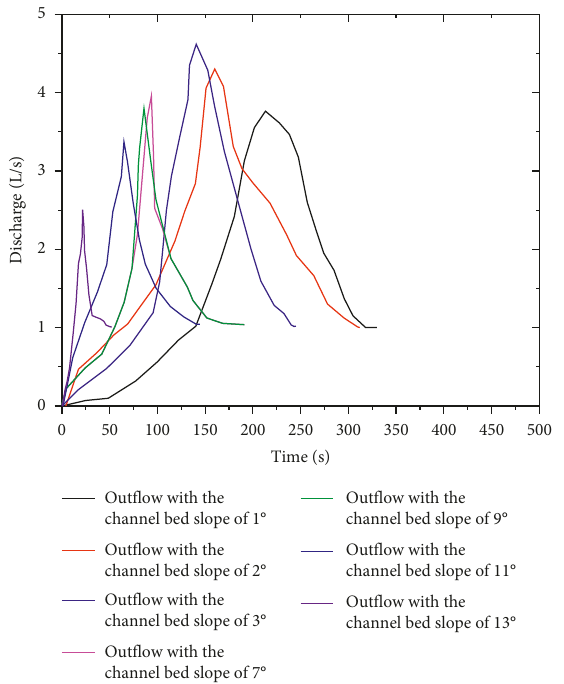
Figure 5: Breach discharge hydrographs for different channel bed slopes.